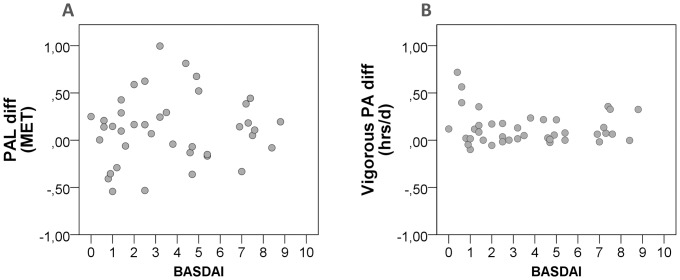
Scatterplots of healthy control versus axial spondyloarthritis (aSpA) difference scores and disease activity as measured by the Bath Ankylosing Spondylitis Disease Activity Index (BASDAI): Physical activity level (PAL) A) and Vigorous PA (B); PA, physical activity; MET, metabolic equivalent; diff, difference score: for each matched pair (n = 40 pairs) healthy control value minus aSpA patient value.